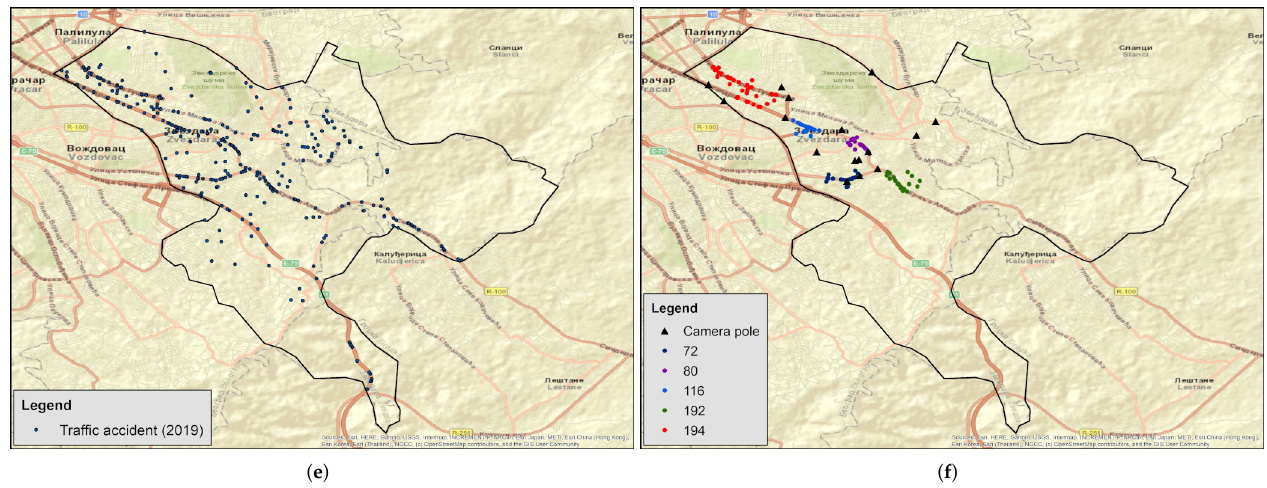
Figure 5. On the left: the maps showing road traffic accidents with injuries or death that occurred in the Municipality of Zvezdara during ( a ) 2021, ( c ) 2020, and ( e ) 2019. On the right: the corresponding map representations of the obtained clusters. The camera pole locations (March 2022) are represented for the purpose of completeness. ( a ) Traffic accidents, Zvezdara, 2021. ( b ) Selected clusters, Zvezdara, 2021. ( c ) Traffic accidents, Zvezdara, 2020. ( d ) Selected clusters, Zvezdara, 2020. ( e ) Traffic accidents, Zvezdara, 2019. ( f ) Selected clusters, Zvezdara, 2019. The maps were generated using the ArcMap component of the Esri’s ArcGIS suite